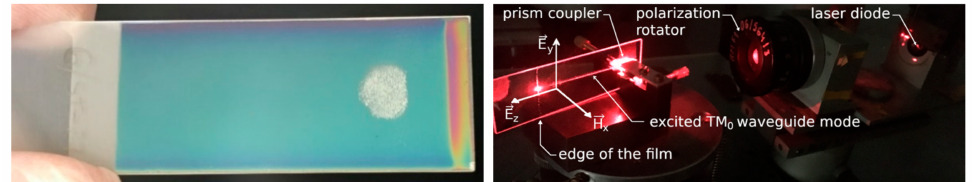
Figure 4. The picture on the left presents the waveguide film illuminated with white light revealing its interference color. The picture on the right presents the streak of scattered light accompanying propagation of the TM 0 mode.